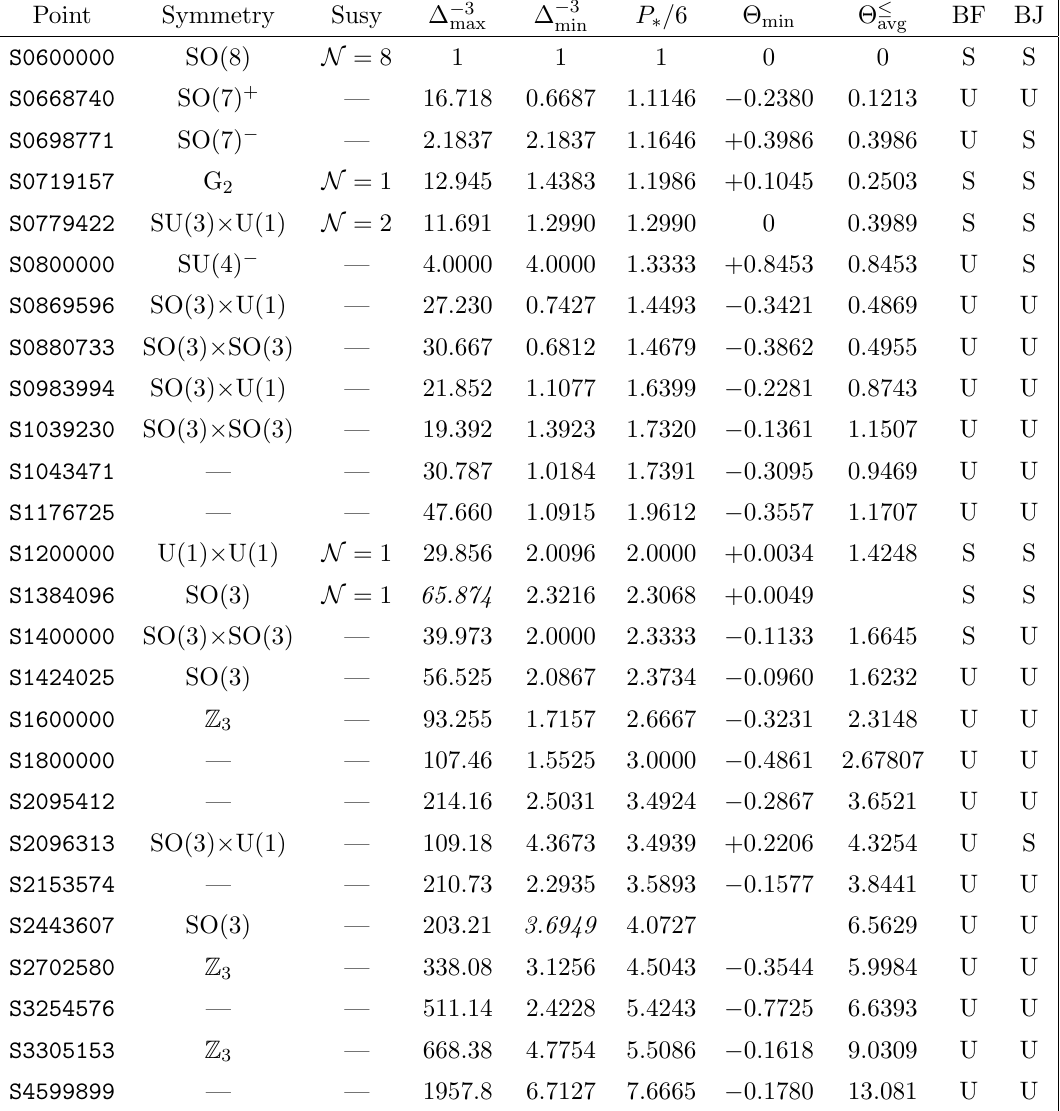
Table 1 . Numerical estimates for the stability parameters of some of critical points of gauged N = 8 supergravity in four dimensions. The quantity (cid:2) (cid:20) is a lower bound on the average of (cid:2). avg \BF" and \BJ" catalogue the Breitenlohner-Freedman and Brane-Jet (in)stability with S = stable, and U = unstable. The italicized entries are based on an approximation discussed in appendix